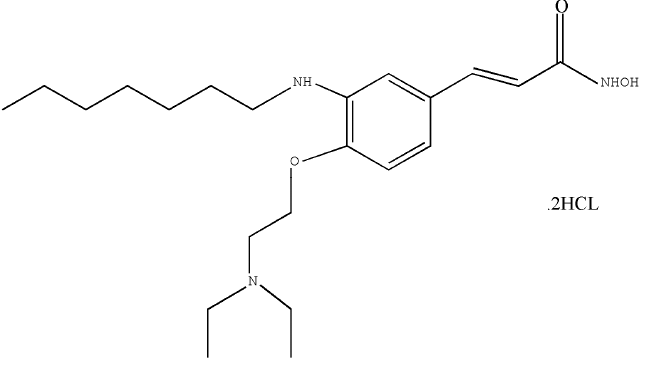
Figure 1. Chemical structure of HZ1006.